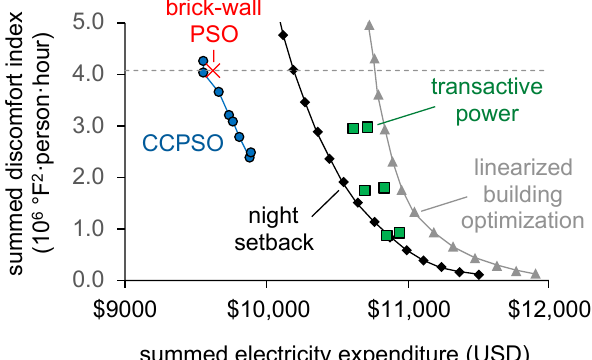
Figure 5. Cost and comfort when optimizing t set over August 2007 using five different control strategies. Cost-Comfort Particle Swarm Optimization (CCPSO) finds solutions that simultaneously reduce both discomfort and cost relative to other methods. See text for details on each